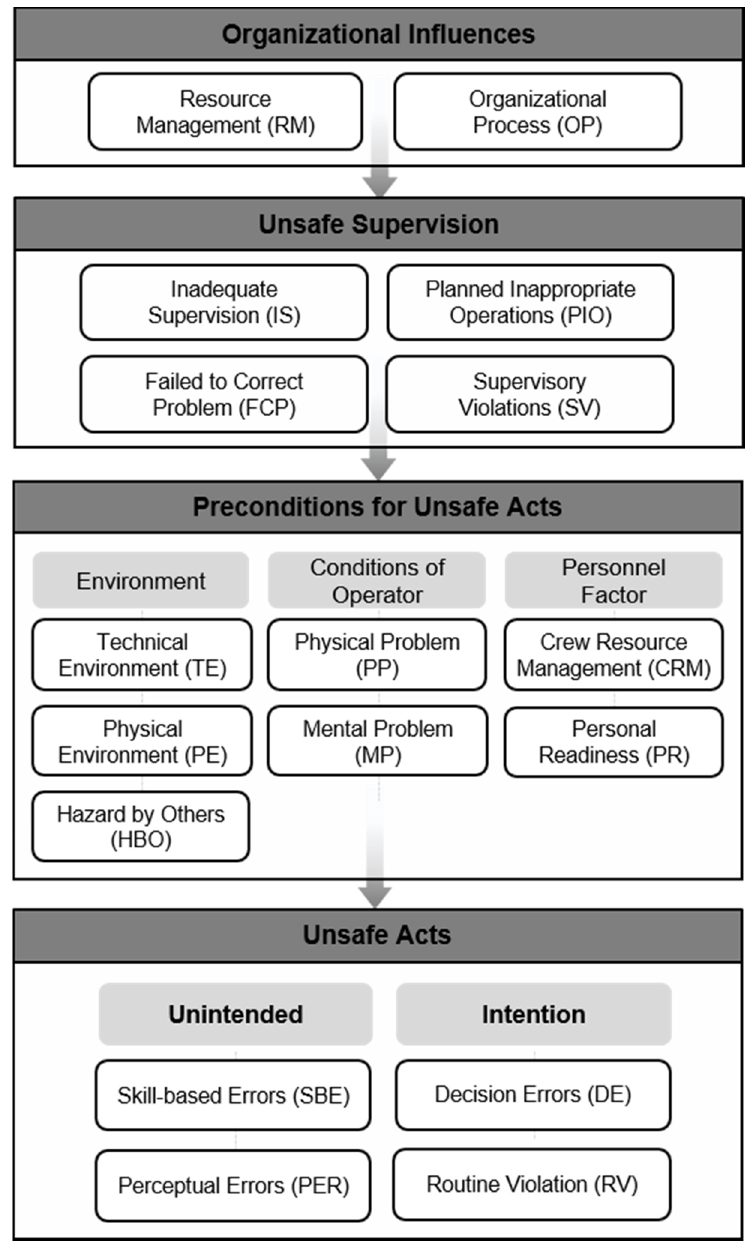
Figure 3. The modified HFACS used in this study.